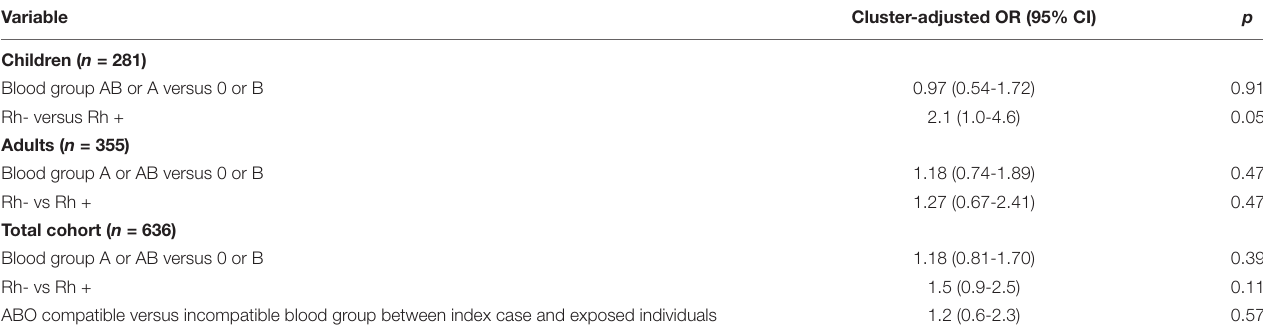
TABLE 3 | Risk of household members having blood group AB or A versus 0 or B or being Rh-negative versus Rh-positive for SARS-CoV-2 seropositivity.